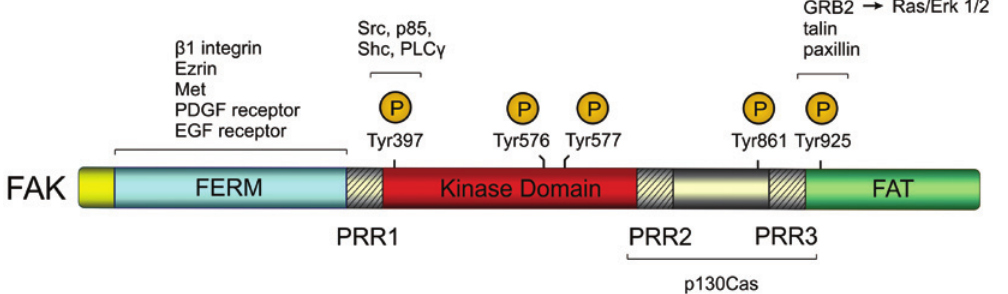
Figure 3: Domain structure and phosphorylation sites of